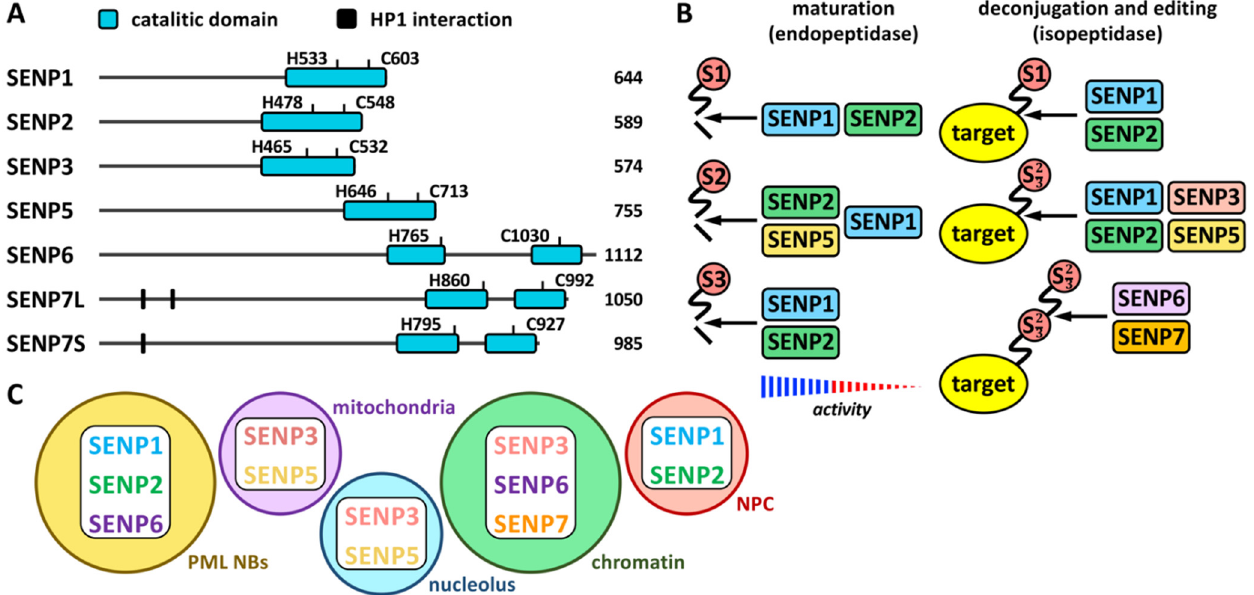
Figure 2. The SENP family. ( A ) Schematic representation of human SENP proteins with the C-ter- minal catalytic domain and the key His (H) and Cys ( C ) residues. HP1 interacting domains are also shown on SENP7, for which two isoforms have been described: large (SENP7L) and short (SENP7S), lacking the latter of one of the HP1 interacting motifs. The number of amino acids is also shown for each protein. ( B ) Endopeptidase (maturation) and isopeptidase (deconjugation and editing) activi- ties for each SENP protein are shown. Strength of activity in relation to paralog preference is indi- cated for maturation activity. ( C ) Localization of SENP proteins to different cellular compartments is schematically represented. NPC, nuclear pore complex.